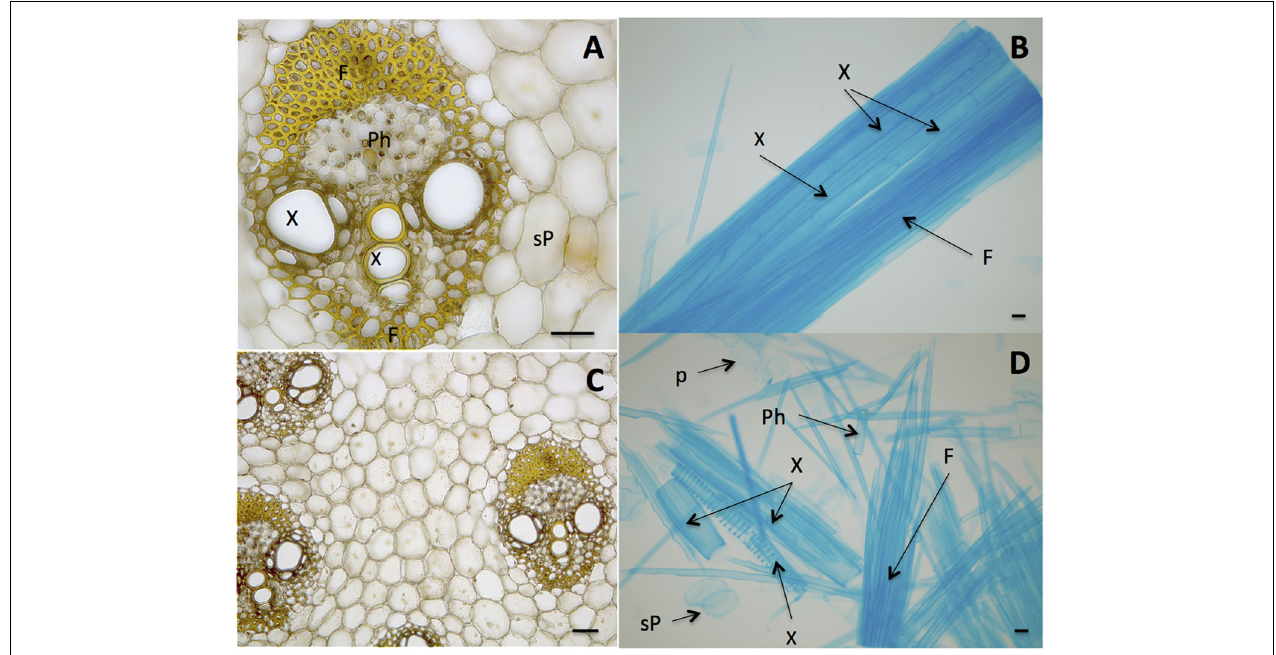
FIGURE 1 | Biomass units of sugarcane stem (culm) with cells bound by middle lamellae. (A,C) Stele, the vascular bundle showing Fibers (F), Phloem (Ph), Xylem (X), sucrose-storage parenchyma (sP). (B) Macerated tissue showing a detail of an isolated stele that still maintains adhesion among cells. (D) Cells of sugarcane stem without the binding of middle lamellae. Cells are named as in (A) . The cell separation was prepared according to Franklin (1945) and cells were stained with toluidine blue (B,D) and iodine-potassium iodide (A,C) . Bars represent 100 µ